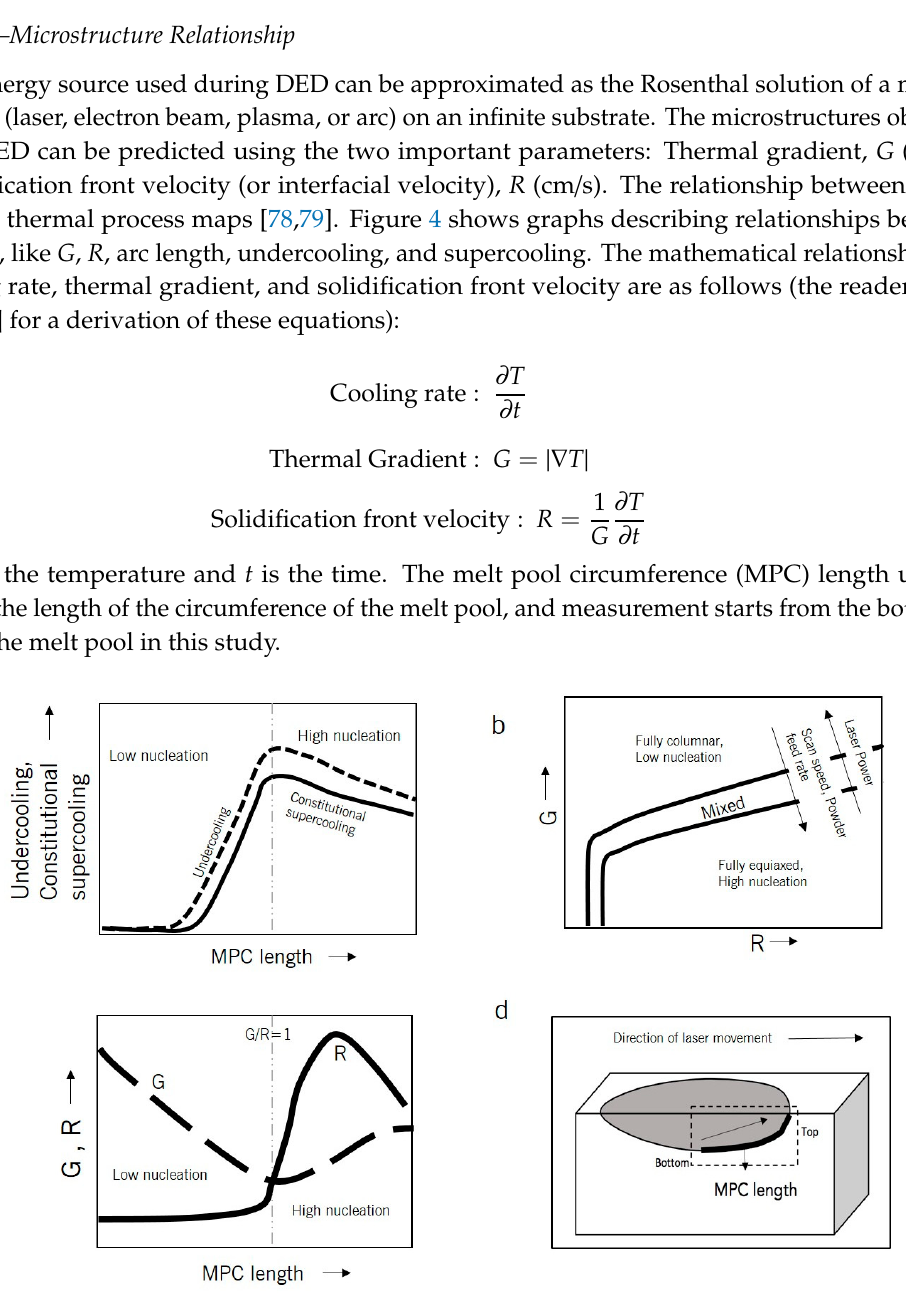
Figure 4. The relationships explaining the process maps for G vs. R , derived from [80]; ( a ) graph of undercooling/constitutional supercooling versus melt pool circumference (MPC) length showing the transition from low nucleation to high nucleation (columnar to equiaxed transition), ( b ) trend of the columnar to equiaxed transition from the graph of G versus R , ( c ) variation of the G / R ratio with respect to the MPC length, and ( d ) the MPC length as defined from the bottom to the top.